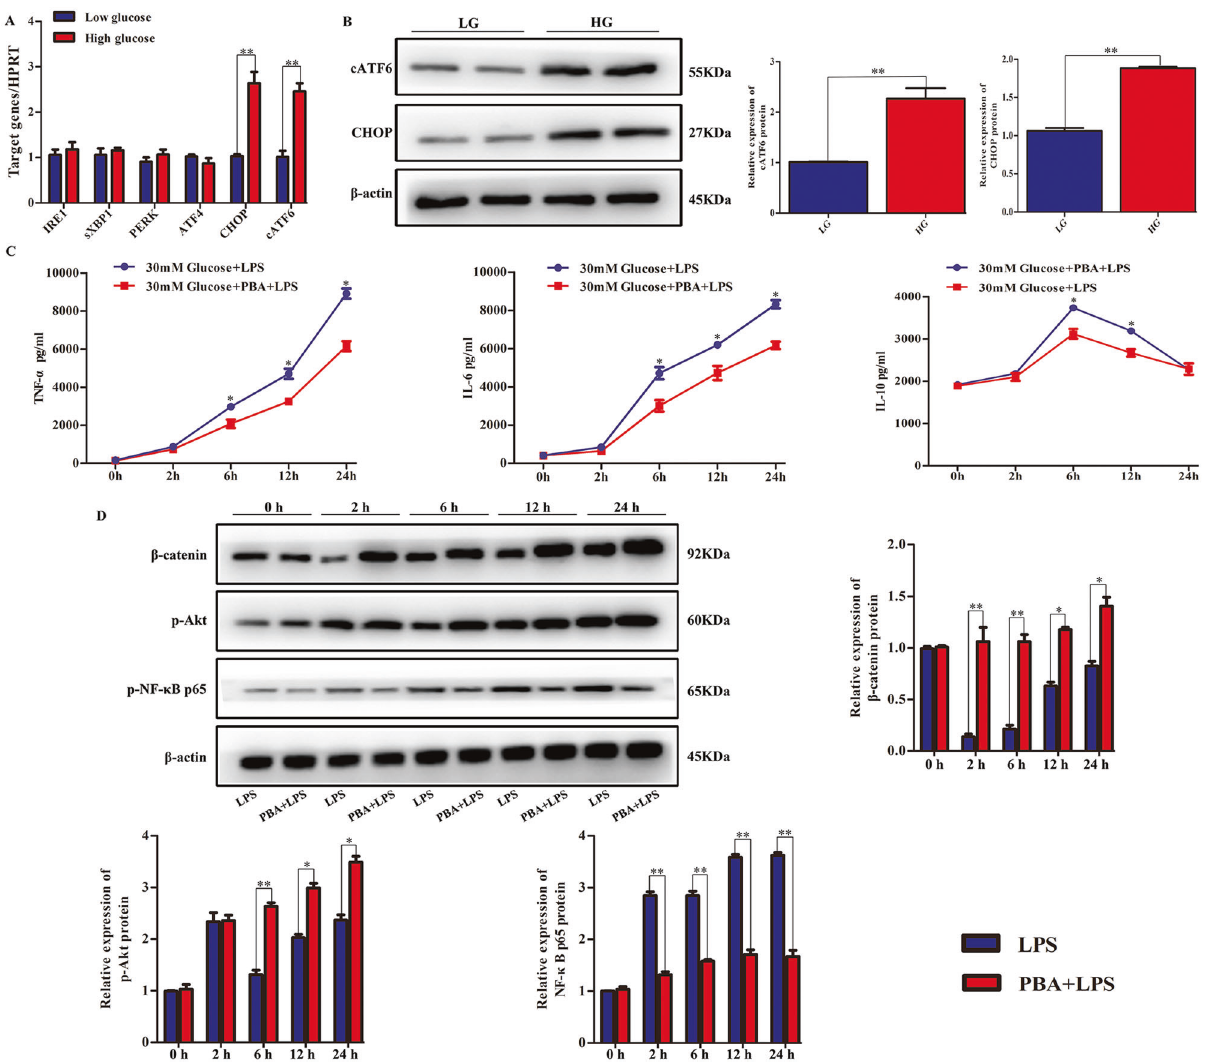
measured by western blot. PBA was added into BMDMs cultured in HG DMEM and were stimulated by LPS for another 24 h; untreated BMDMs differentiated under HG conditions were used as controls. C Protein levels of TNF- α , IL-6, and IL-10 in culture supernatants measured by